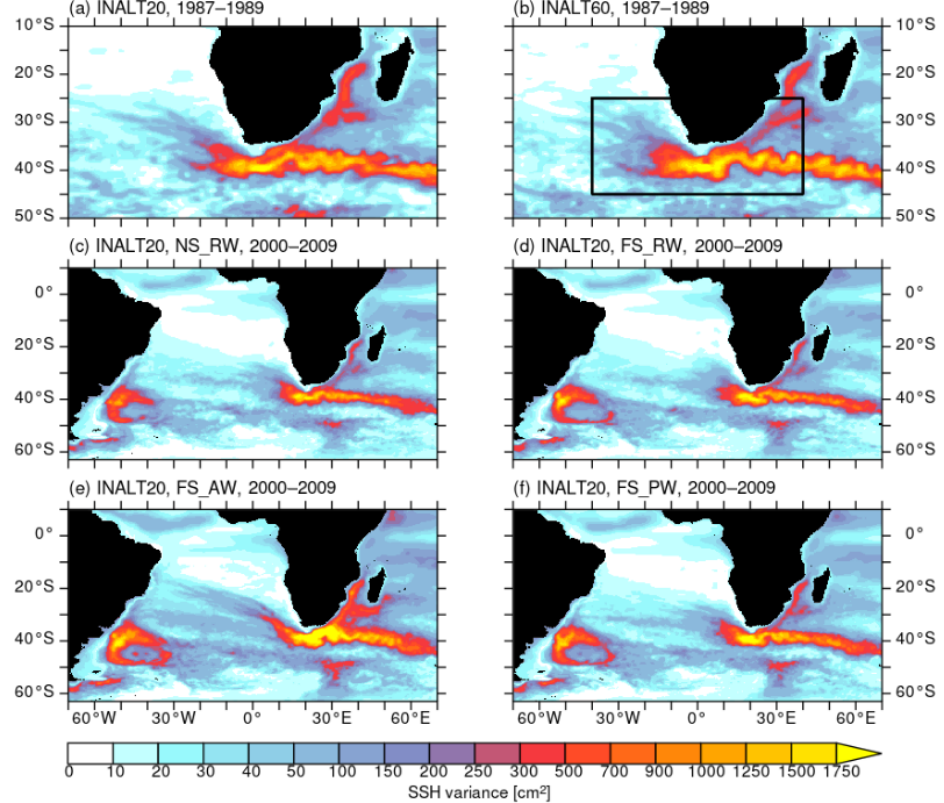
Figure 4. SSH variance (in cm 2 ) for the period 1987 to 1989 from the spin-up experiments in (a) INALT20 and (b) INALT60 based on 5d averages. The black box in panel (b) marks the region of the secondary 1/60 ◦ nest in INALT60. Panels (c) to (f) give the SSH variance (in cm 2 ) for the period 2000–2009 based on 5d averages from the different sensitivity experiments in INALT20: (c) no slip, relative winds, (d) free slip, relative winds, (e) free slip, absolute winds, (f) free slip, partial